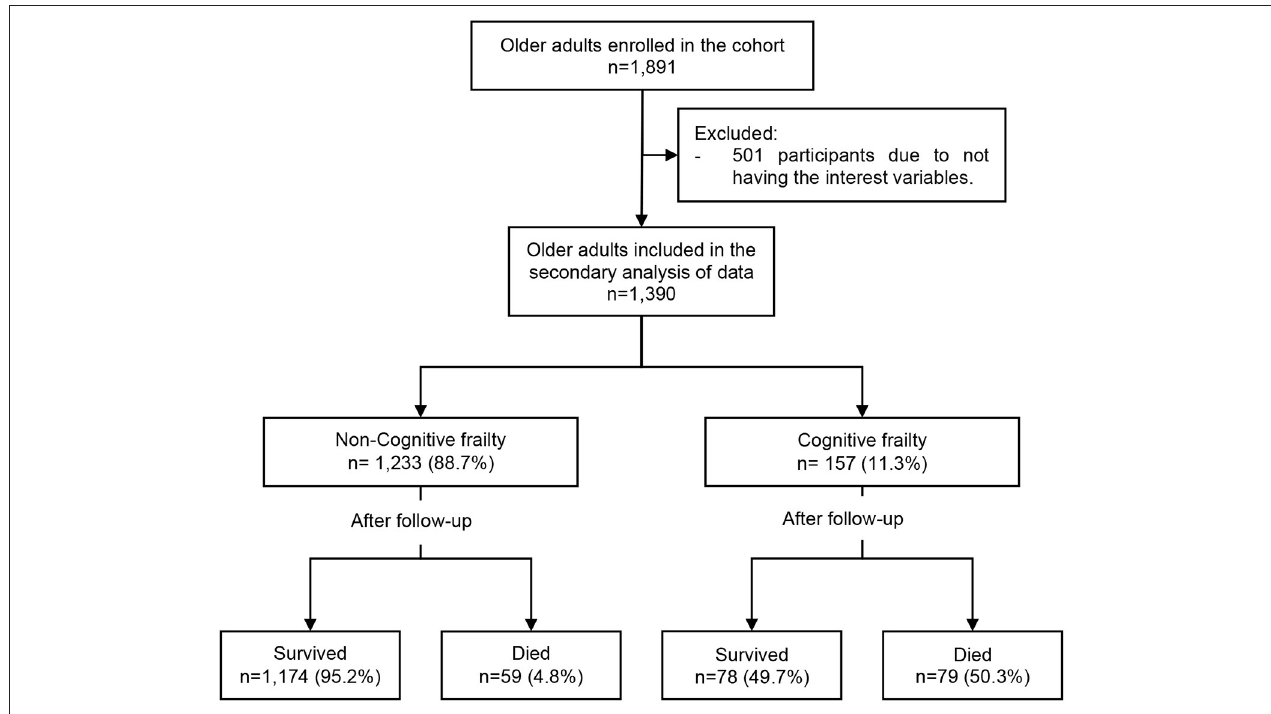
FIGURE 1 | Flowchart of the sample